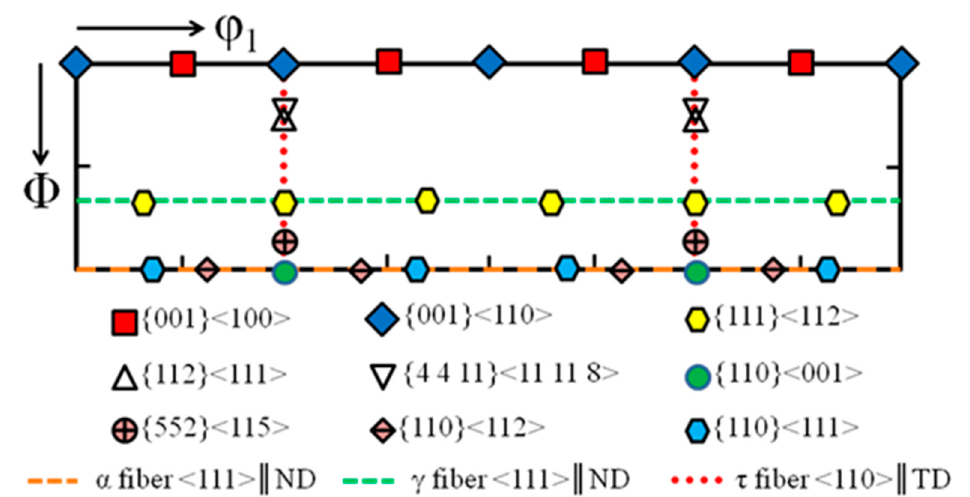
Figure 11. Texture components/fibers and their positions in the orientation space using triclinic sample symmetry for the orientation distribution function (ODF) sections ( φ 2 = 45°) for the copper tube.